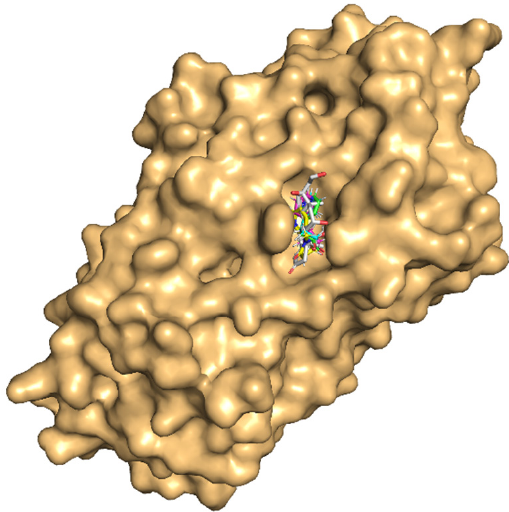
Figure 5. Molecular docking of nicotine and its three important metabolites with the ligand-binding site of corticosteroid-binding globulin (CBG). CBG is in surface representation colored light orange. The ligands are shown in stick representation together in the binding site for easy comparison of the binding poses. The backbones of the compounds are colored differently: native ligand (cortisol) in white, nicotine in magenta, cotinine in cyan, trans-3 (cid:48) -hydroxycotinine in green, and 5 (cid:48) -hydroxycotinine in yellow. The heteroatoms of the compounds oxygen (O) and nitrogen (N) are in blue and red colors,